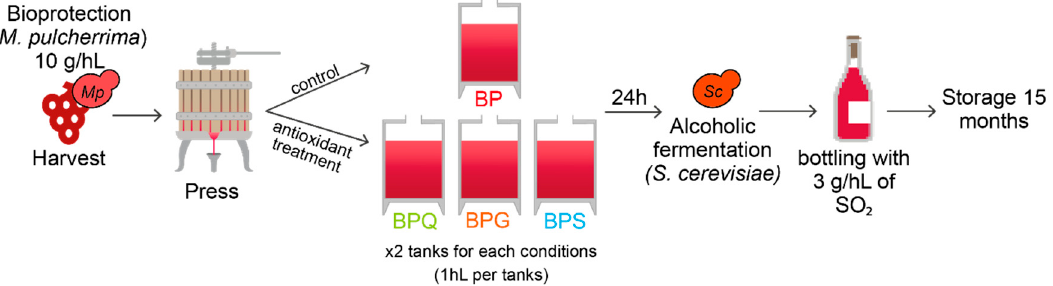
Figure 1. Shema of experimental conditions. BP: bioprotection (control modality), BPG: bioprotection and gall nut tannin addition (5 g/hL), BPQ: bioprotection and quebracho tannin addition (15 g/hL), BPS: bioprotection and SO 2 addition (5 g/hL).